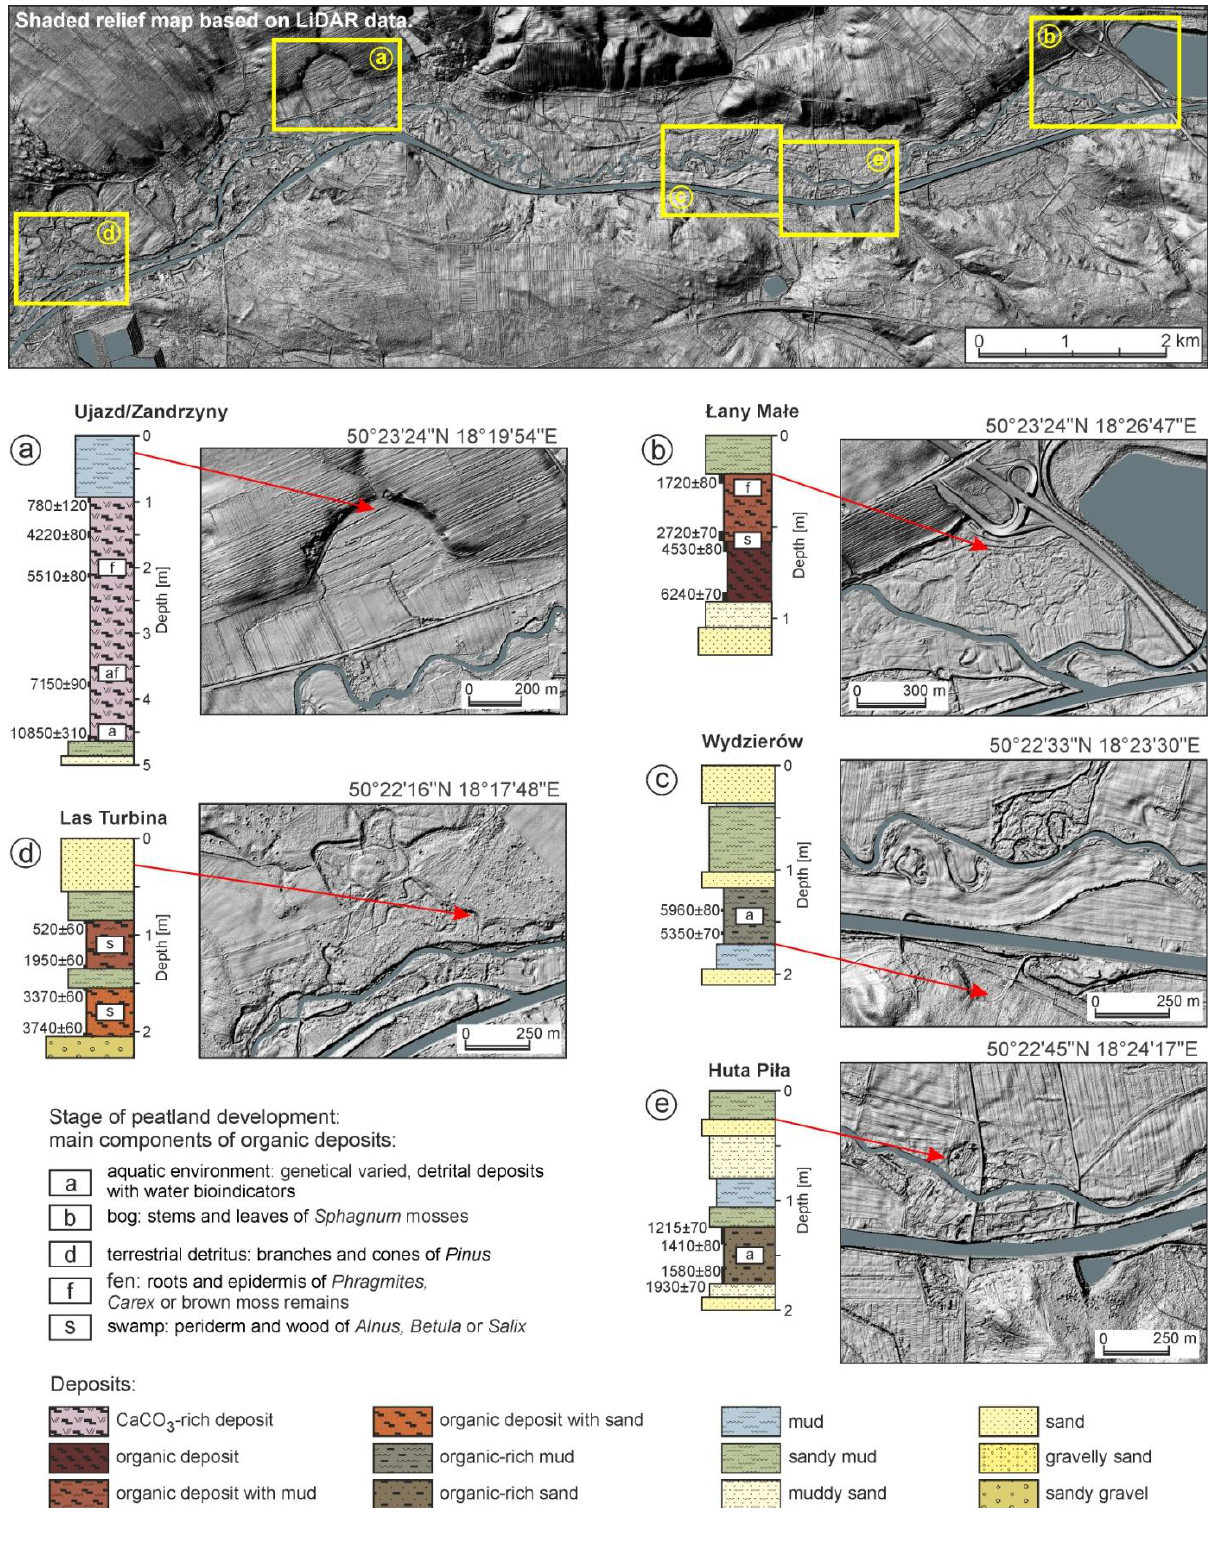
Fig. 3. Radiocarbon-dated sequences of the fossil wetland deposits (shaded relief map based on LiDAR data from